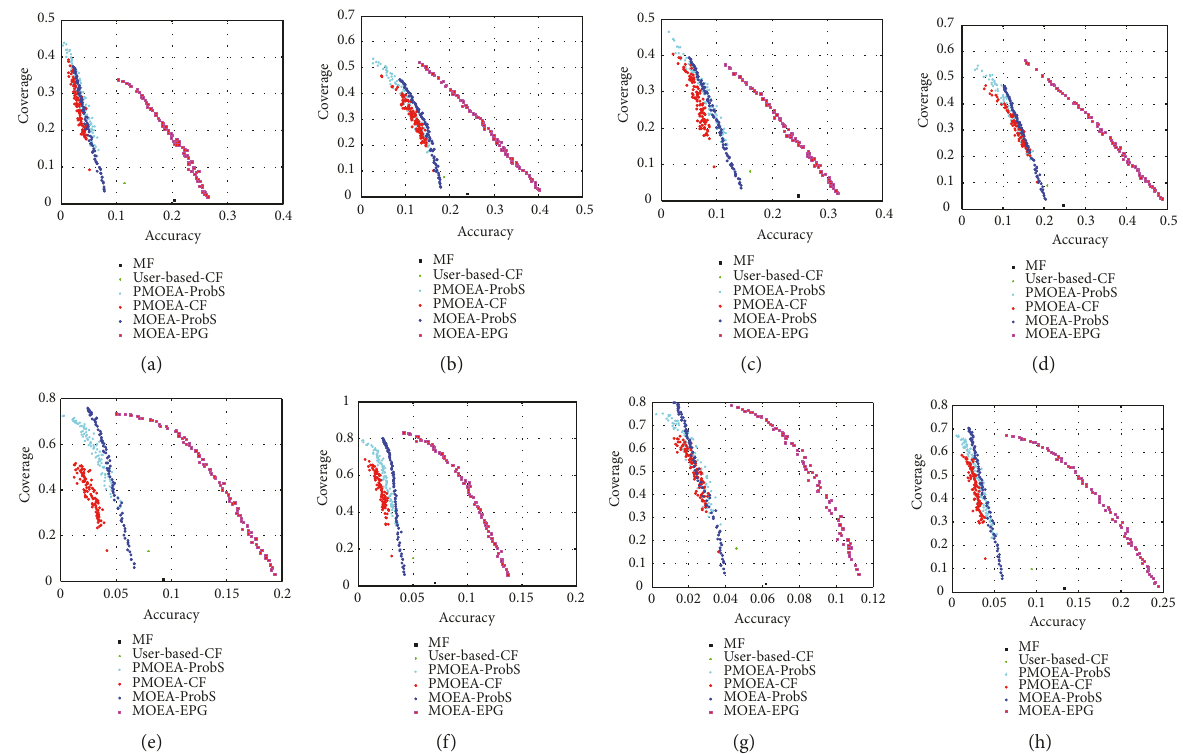
Figure 8: Final recommendation results of comparison algorithms under the accuracy-coverage space for (a) Movielens 1, (b) Movielens 2, (c) Movielens 3, (d) Movielens 4, (e) Netflix 1, (f) Netflix 2, (g) Netflix 3, and (h) Netflix 4.